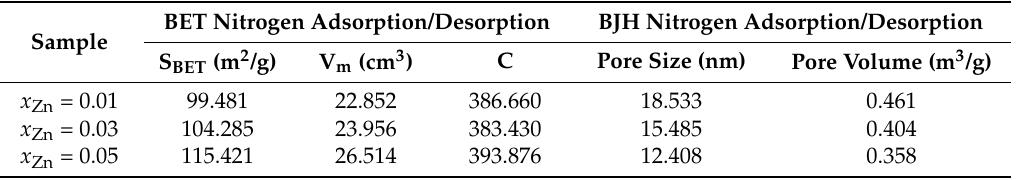
Table 2. Summary of N 2 adsorption/desorption